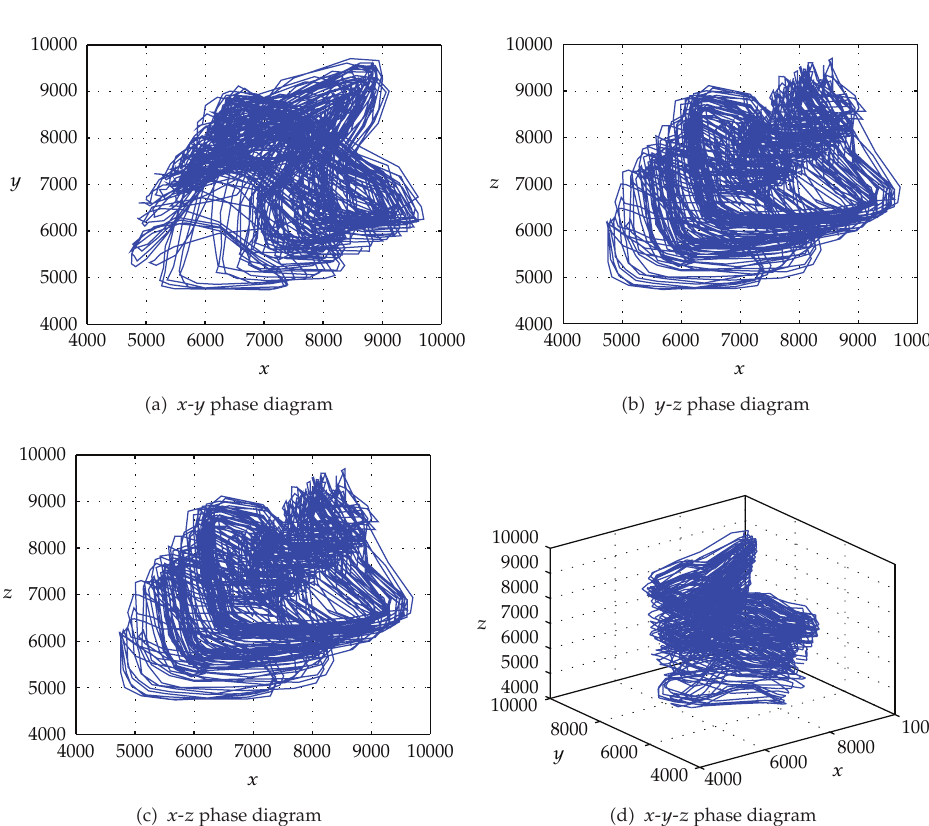
Figure 5: Phase-space